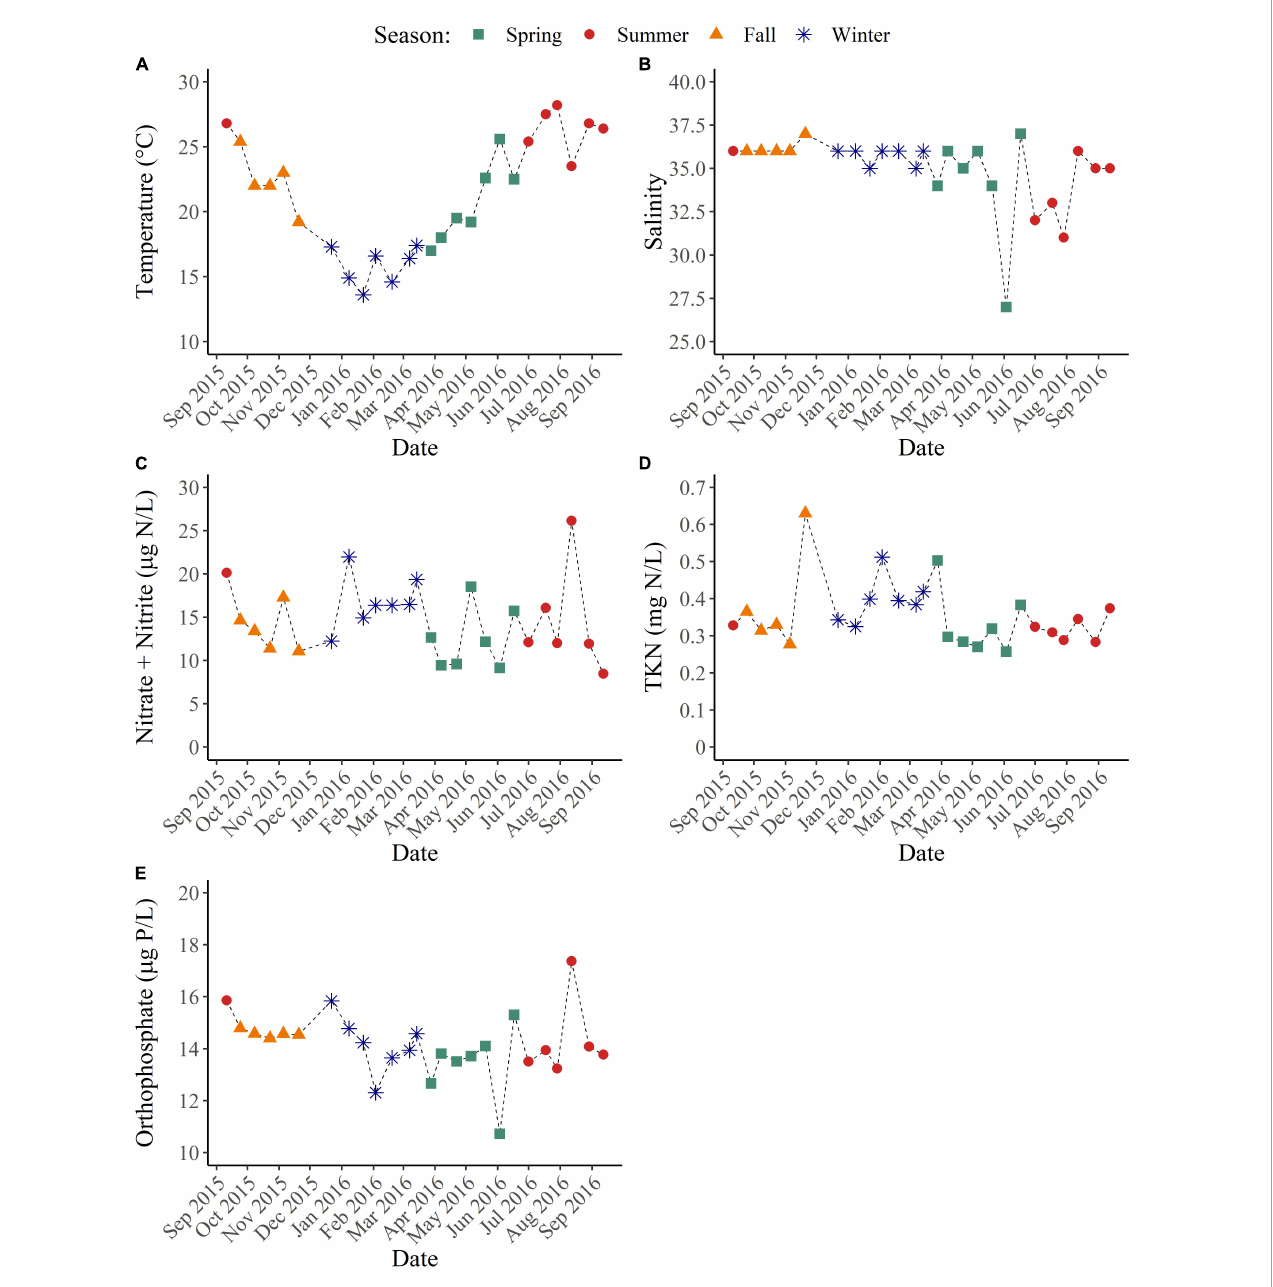
FIGURE1 Environmental conditions of coastal Pensacola Beach waters from 09/2015 to 09/2016. (A) Temperature ( ◦ C). (B) Salinity. (C) NO 3 - + NO 2 - ( µ g N/L). (D) Total Kjeldahl nitrogen (mg N/L). (E) Orthophosphate ( µ g P/L).